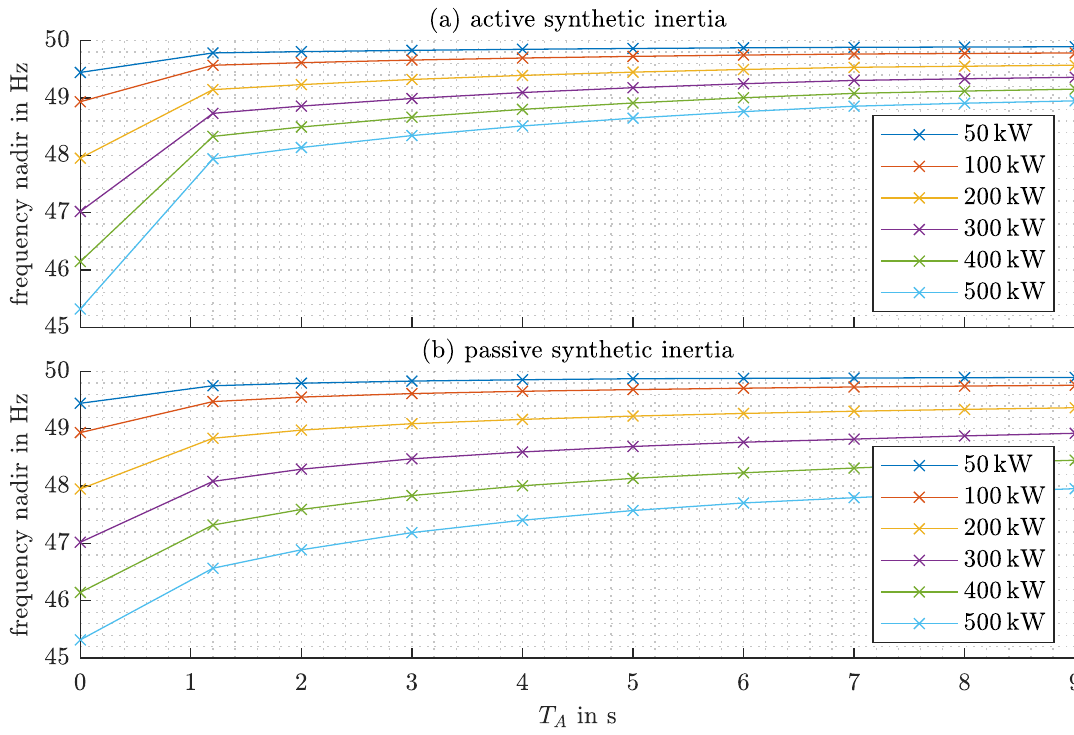
Figure 10. Comparison of frequency nadir for the sensitivity analysis of active- and passive synthetic inertia with varying starting time constants T A of the converter and different